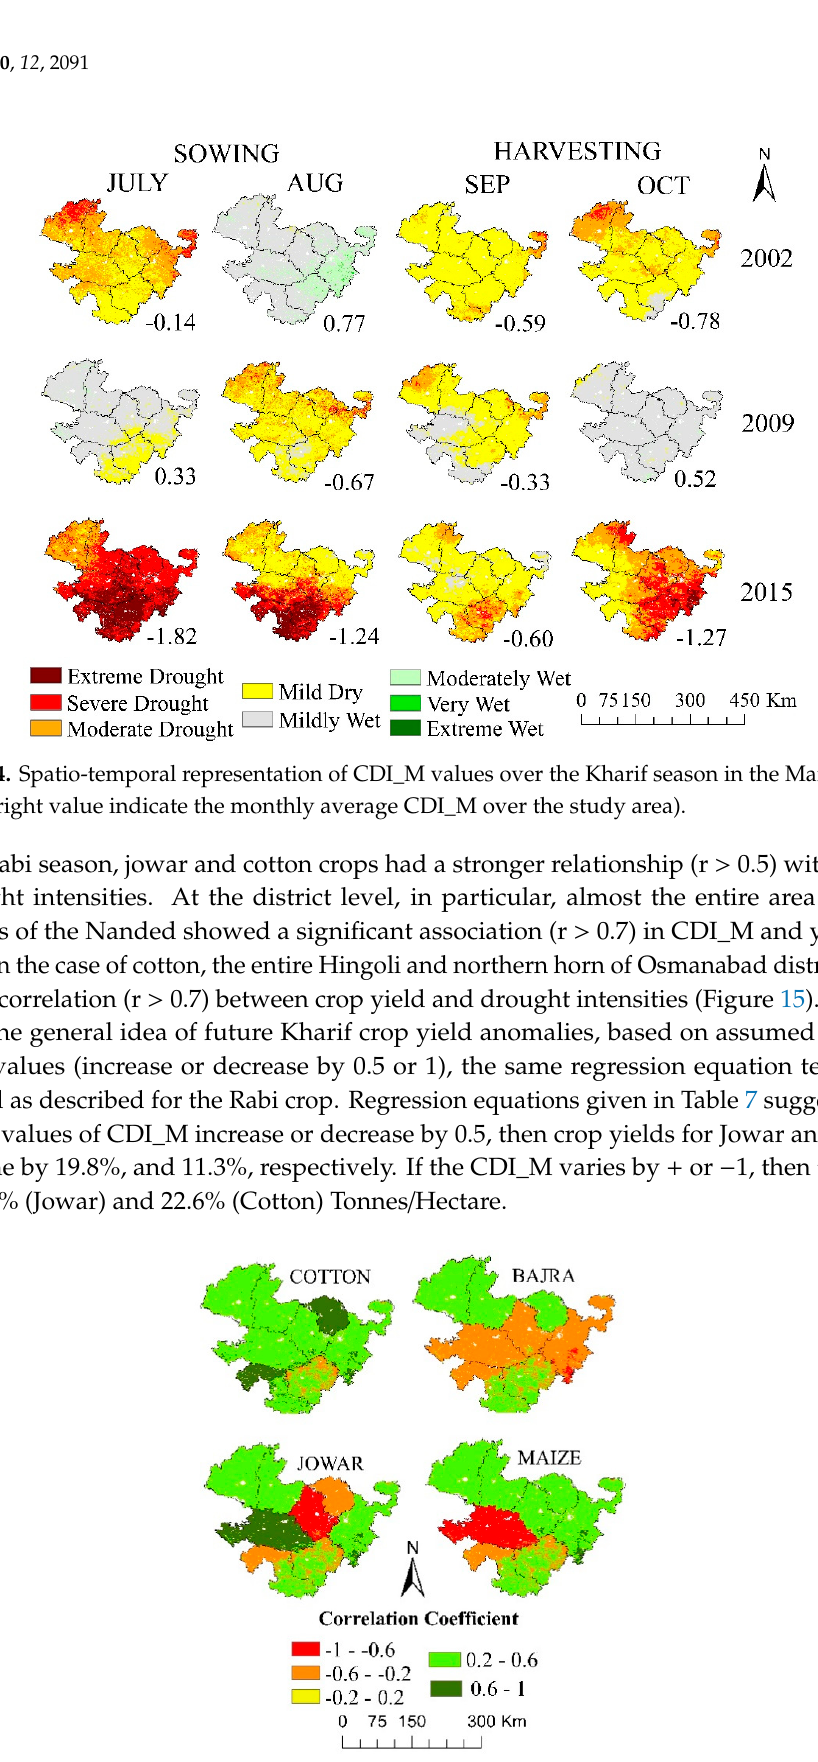
Figure 15. Spatial variations in the correlation coefficient values between Kharif crop yields and CDI_M in Marathwada. Table 7. Correlation and regression between CDI values and crop yield anomalies for the Kharif season. Kharif Crops R Regression Equation Jowar 0.57 Jowar Yield = 0.395(CDI) + 1.178 Cotton 0.67